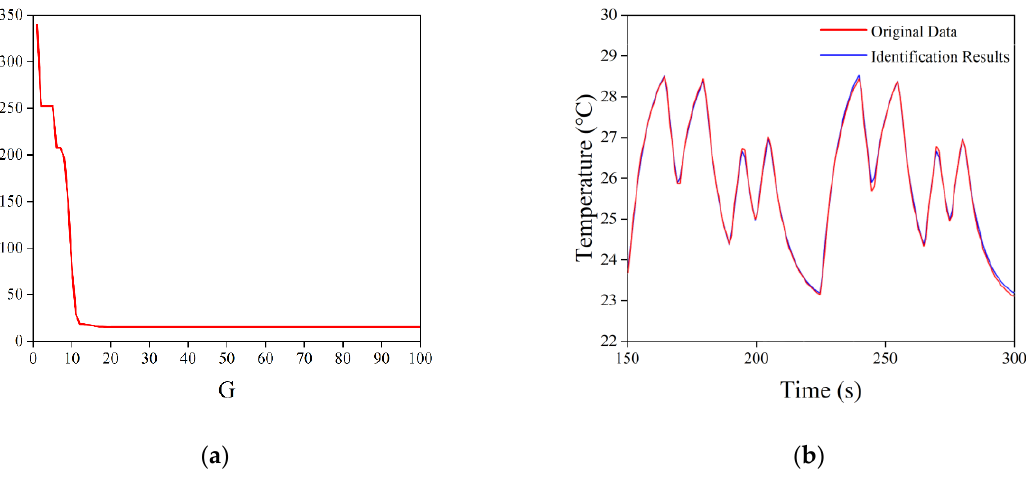
Figure 10. Identification results of the DE algorithm. ( a ) Change curve in the value of the fitness function. ( b ) Comparison curves of the identification results with the original data.